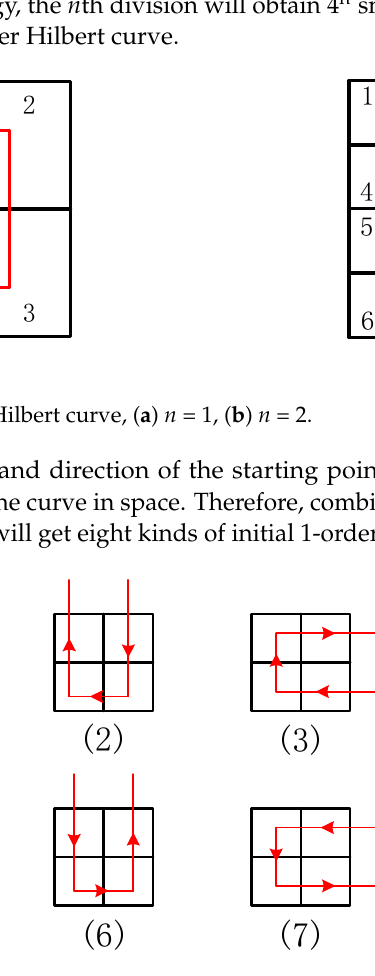
Figure 6. Eight 1-order Hilbert curves.